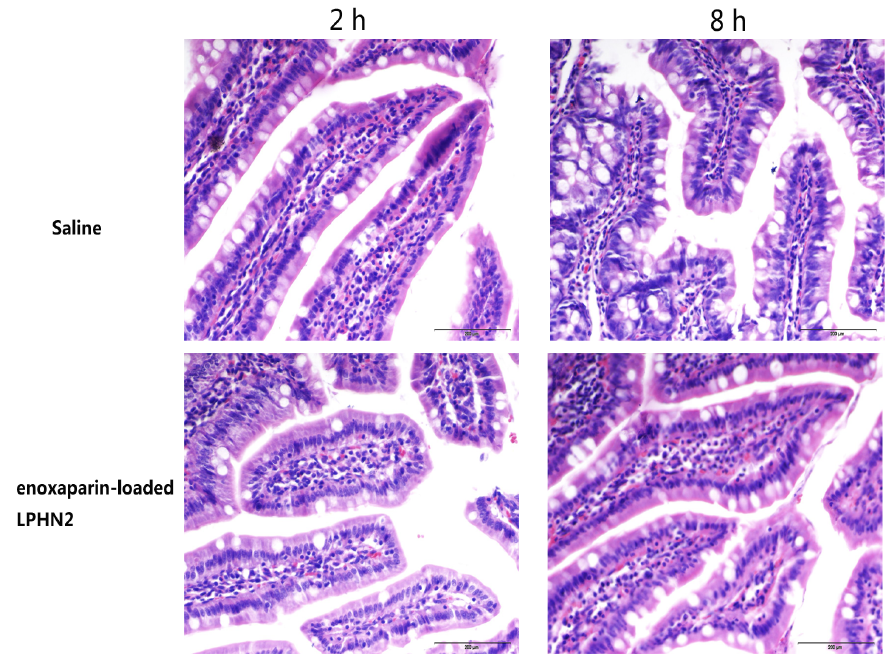
Figure 4. Morphology of intestinal mucosa of rats after oral administration of physiological saline- and enoxaparin-loaded LPHN2 after 2 and 8 h. Scale bar: 200 μm